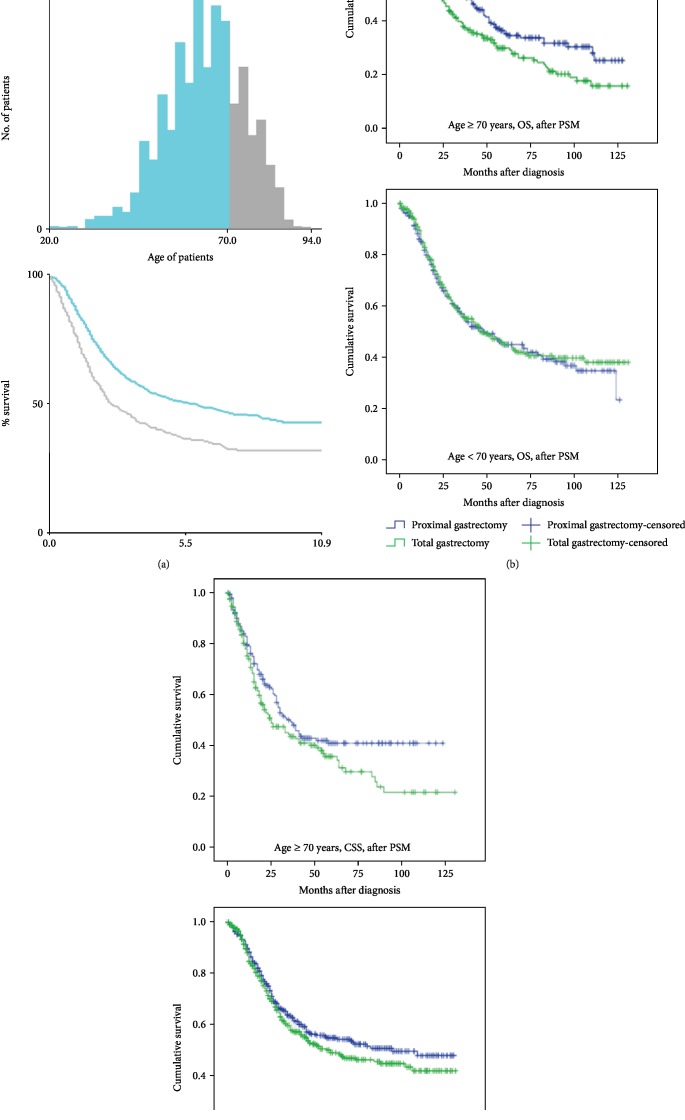
OS analysis of the age subgroups. (a) Results of the X-tile analysis of OS data of 2,217 Siewert type II AEG patients with age as a factor. The optimal cut-off value for the patients' age is shown on a histogram and Kaplan-Meier curves. The X-tail analysis showed that 70 years was the optimal cut-off value. (b) Kaplan-Meier analysis of OS between the PG and TG patients in the subgroups of patients aged < 70 years (χ2 = 0.167, p = 0.682) and those aged ≥ 70 years (χ2 = 8.245, p = 0.004). (c) Kaplan-Meier analysis of CSS analysis between the PG and TG patients in the subgroups of patients aged < 70 years (χ2 = 1.686, p = 0.194) and those aged ≥ 70 years (χ2 = 3.895, p = 0.048).